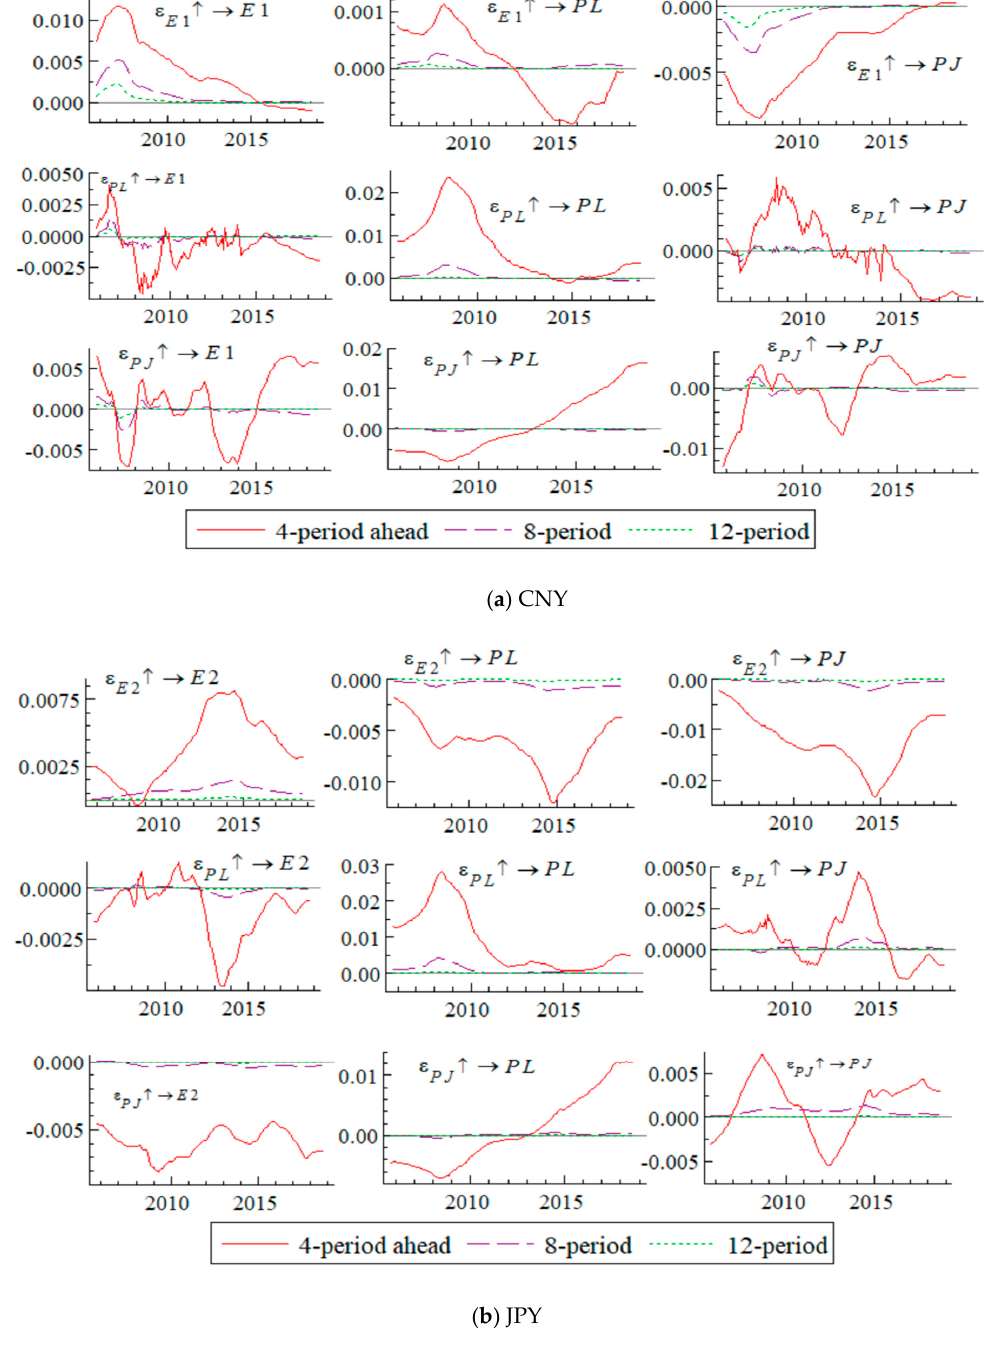
Figure 3. Posterior mean of the impulse response functions.